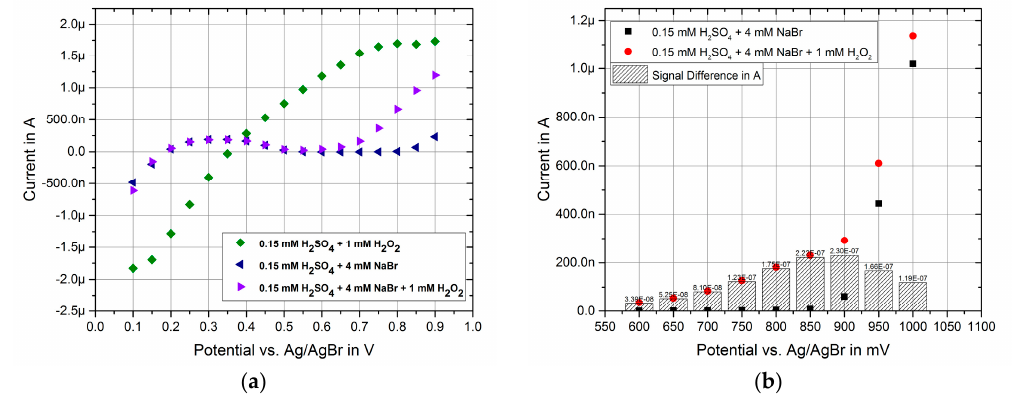
Figure 2. ( a ) Results for chrono amperometric measurements to determine the influence of the bromide ions in the electrolyte solution. The presence of bromide inhibits the direct oxidation of hydrogen peroxide in the potential range of 400 mV to 700 mV vs. Ag/AgBr; ( b ) Due to the oxidation of bromide ions, a trade-off between high detection and low background signal has to be made. To obtain selective results for the amperometric measurement of H 2 O 2 , a potential of 850 mV was